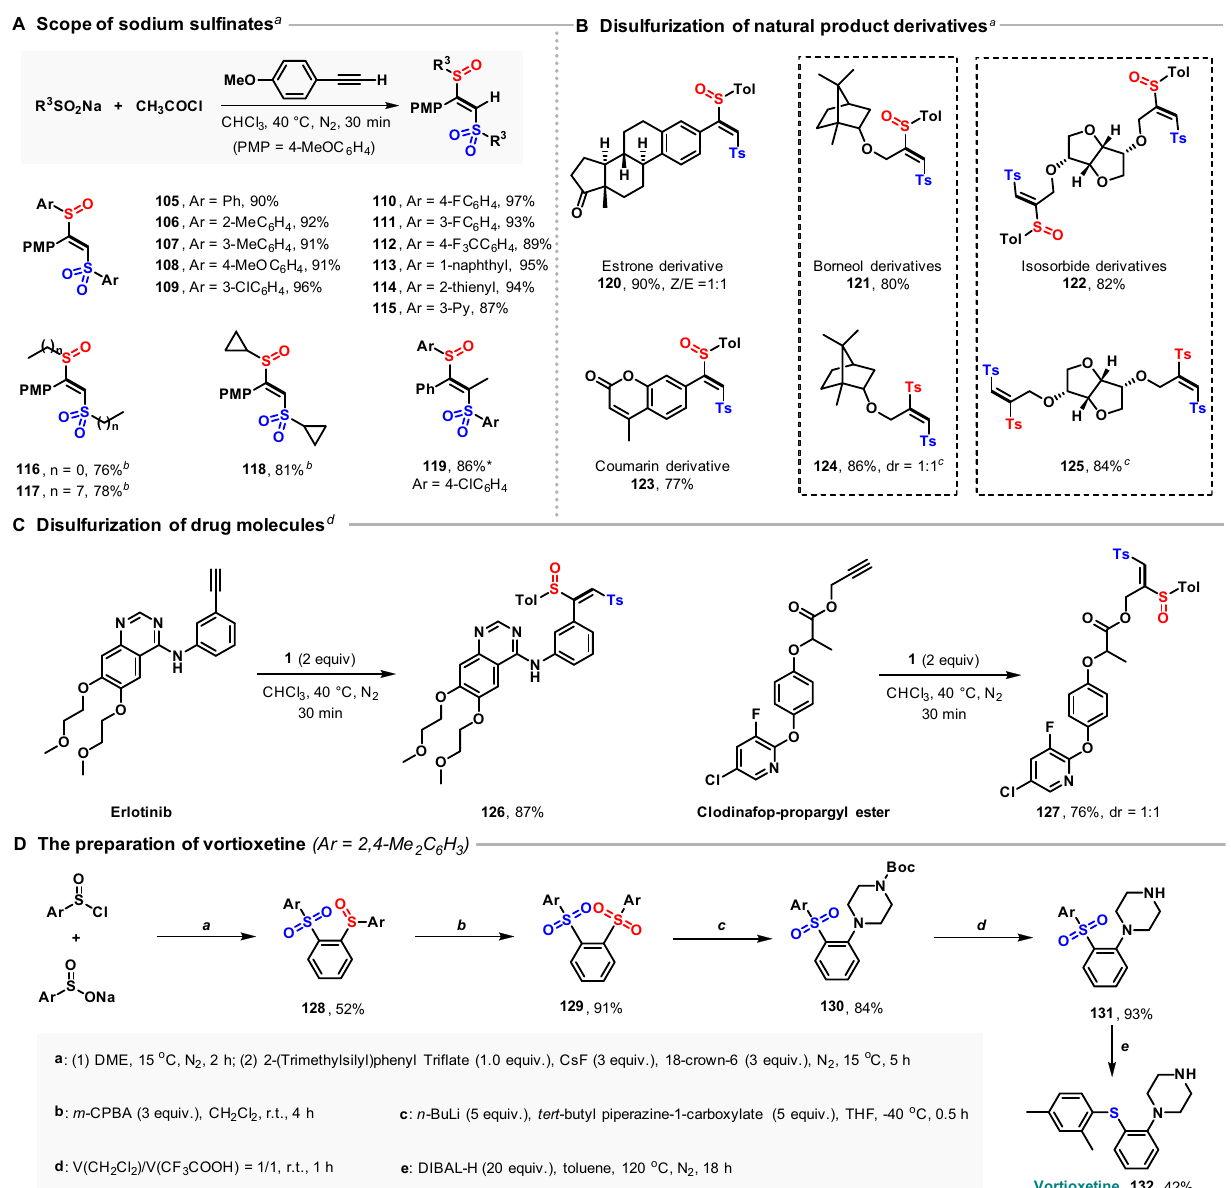
Fig. 4 The scope of sodium sulfonates and the application of sul fi nylsulfonation in late-stage functionalization and synthesis of drug molecules. A Variation of the sodium sul fi nate. *Prop-1-yn-1-ylbenzene was used as the substrate; B disulfurization of natural product derivatives; C disulfurization of drug molecules. All yields are isolated yields. Reaction conditions for the synthesis of 105 – 123 : alkyne (0.3 mmol), sodium sul fi nate (1.8 mmol), acetyl chloride (1.2 mmol), 0.1 M in CHCl 3 , N 2 . a 40 °C, 30 min. b 10 °C, 12 h. c 121 or 122 (0.5 mmol), m -CPBA (0.75 mmol), DCM (10 mL), room temperature, 1 h. d Erlotinib or Clodinafop-propargyl ester (0.5 mmol), 1 (1.0 mmol), CHCl 3 (3.0 mmol), 40 °C, N 2 , 0.5 h. D The preparation of